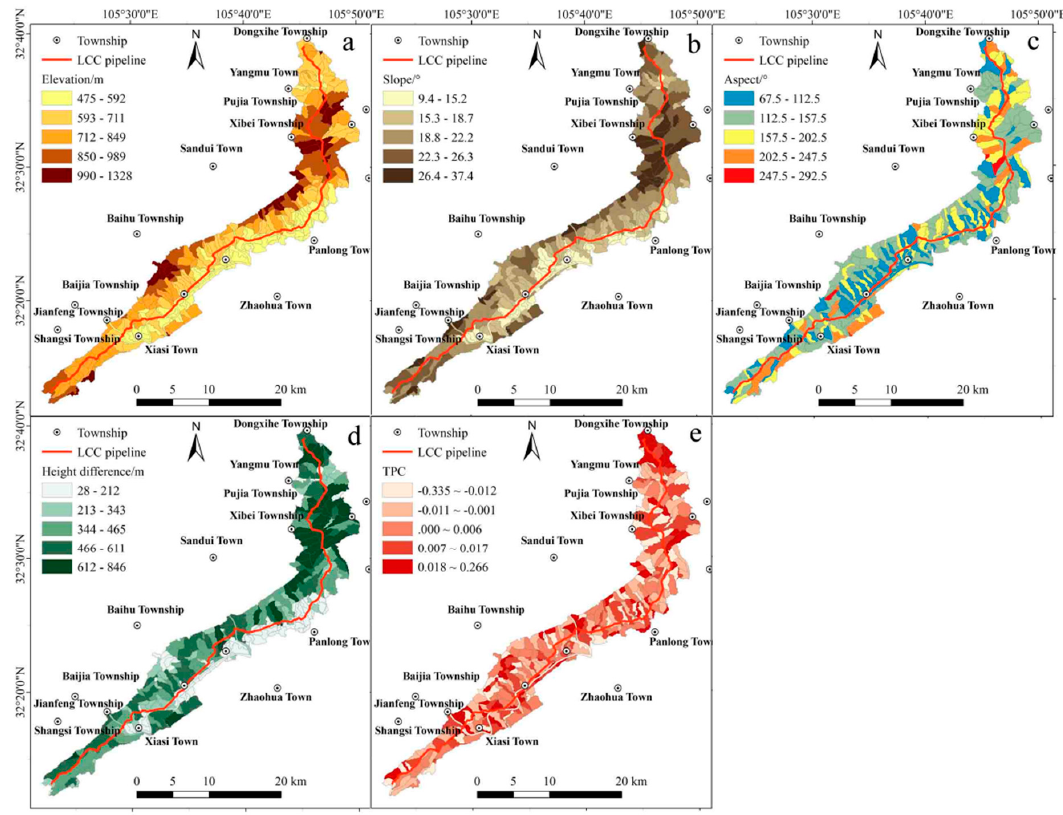
Figure 3. Spatial patterns of single indicator in each slope unit: ( a ) elevation, ( b ) slope, ( c ) aspect, ( d ) height difference, and ( e ) topographic profile curvature (TPC).